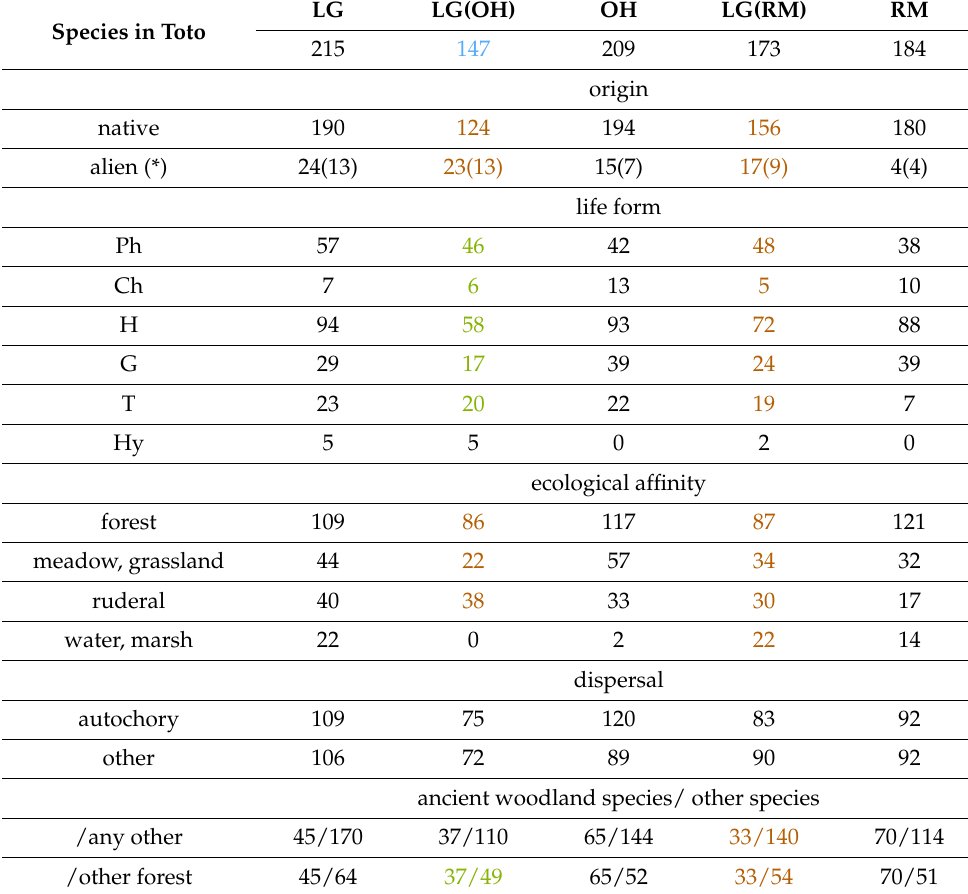
Table 1. Selected characteristics (expressed in species numbers) of the flora of Lisia G ó ra (LG) reserve, represented by deciduous oak-hornbeam forest LG(OH), occupying the plateau and scarp, and riparian- mixed forest LG(RM) in the floodplain part; they are compared to the reference oak-hornbeam OH in Rato´sni ó wki [38] and riparian-mixed forest RM of G ó ra Chełm reserve (T. W ó jcik and M. Ziaja, unpublished data); blue font—significant difference between LG and its reference (Chi-square goodness of fit, p < 0.05); brown ( p < 0.05) and green (0.05 ≤ p < 0.10) font—significant difference of the frequency distribution between LG and reference habitats (Chi-square independence); Ph—phanerophytes, Ch— chamaephytes, H—hemicryptophytes, G—geophytes, T—therophytes, Hy—hydrophytes, in bracktes— number of alien invasive species; See Table S1 for the completed dataset. Species in Toto